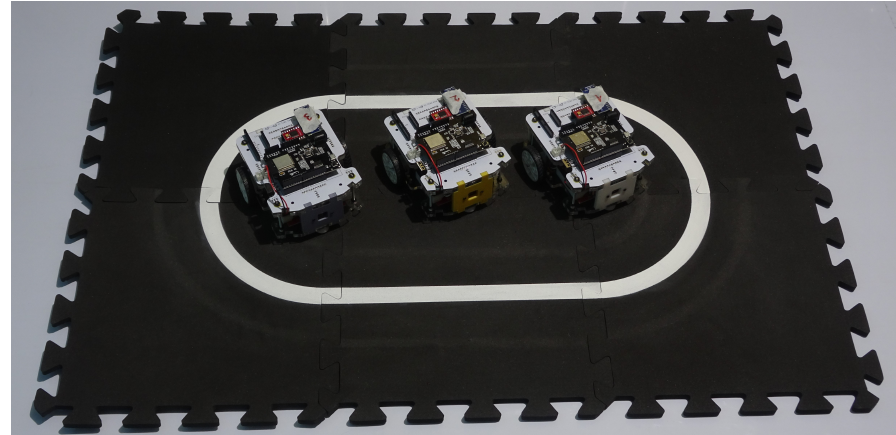
Figure 3. Overview of the RUPU experimental